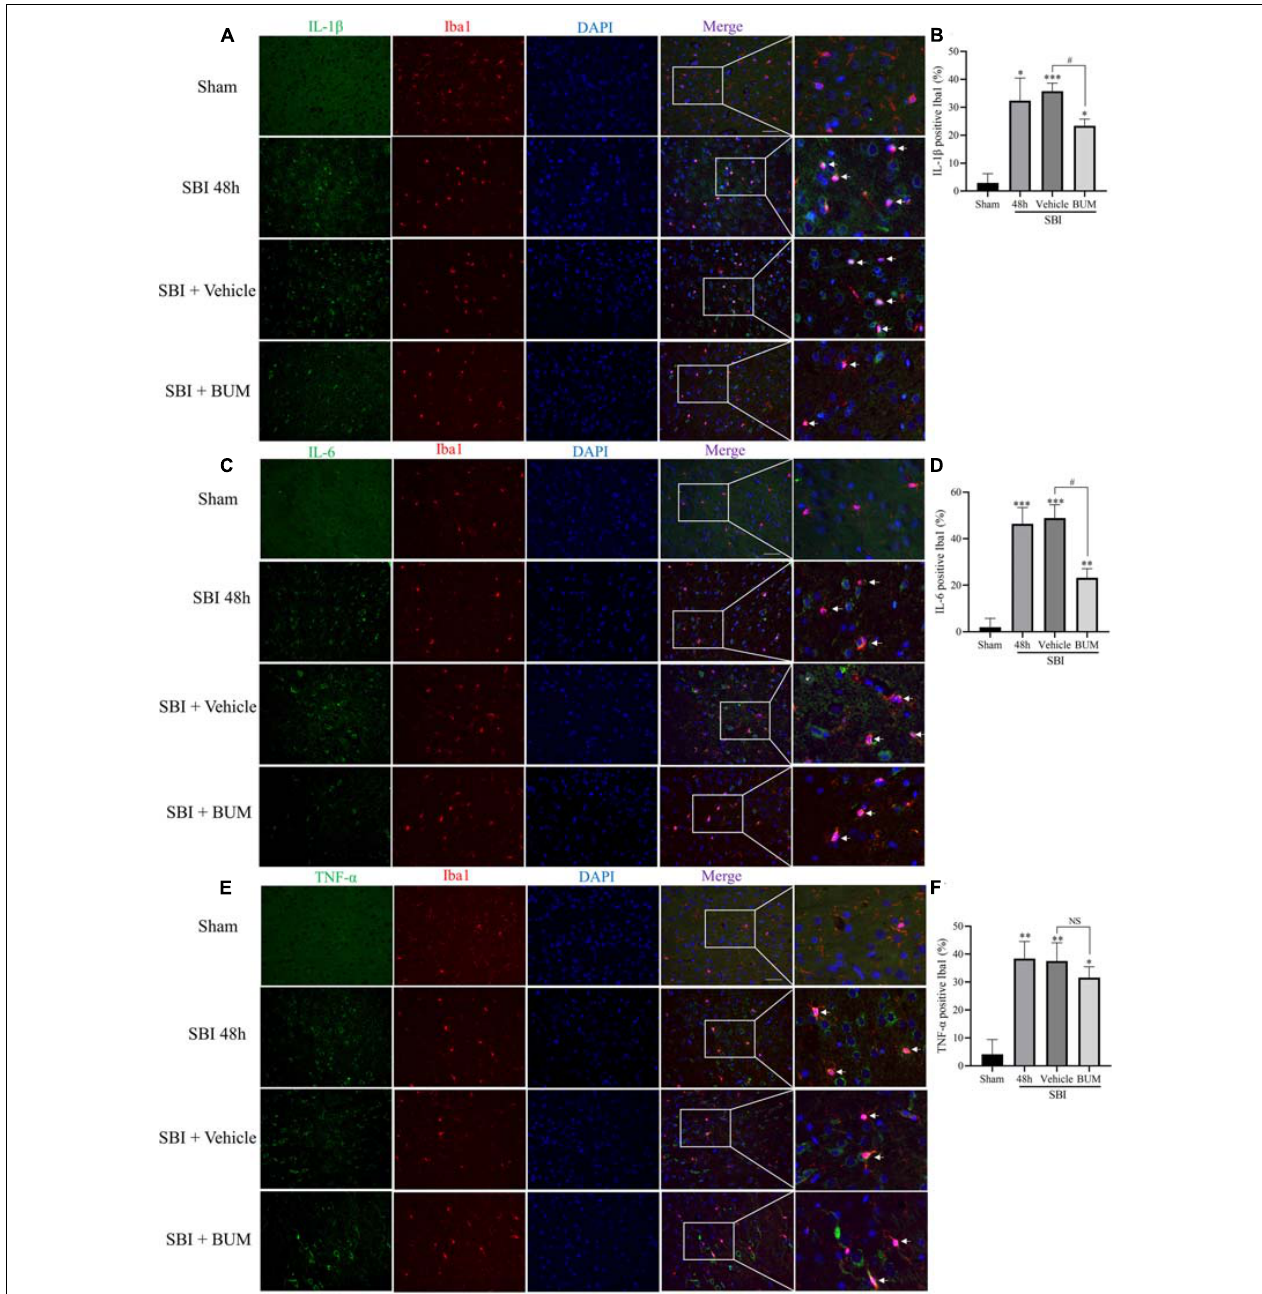
FIGURE 4 | Double IF staining of IL-1 β , IL-6, and TNF- α in the peripheral cortex of the damaged area. In the sham group, SBI group, SBI + vehicle group, and SBI + BUM group, the expression of green-labeled IL-1 β (A,B) , IL-6 (C,D) , TNF- α (E,F) , and red-labeled Iba1 were assessed by double IF. The nuclei were stained with DAPI (blue) fluorescence. Arrows show IL-1 β , IL-6, and TNF- α co-localization with microglial cells. Scale bar = 50 µ m. Statistical analysis was conducted using a K–W one-way ANOVA, followed by the Student–Newman–Keuls post hoc test. n = 4 for each group. ** P < 0.01, *** P < 0.001, compared with sham group. # P < 0 . 05, compared with the SBI + Vehicle